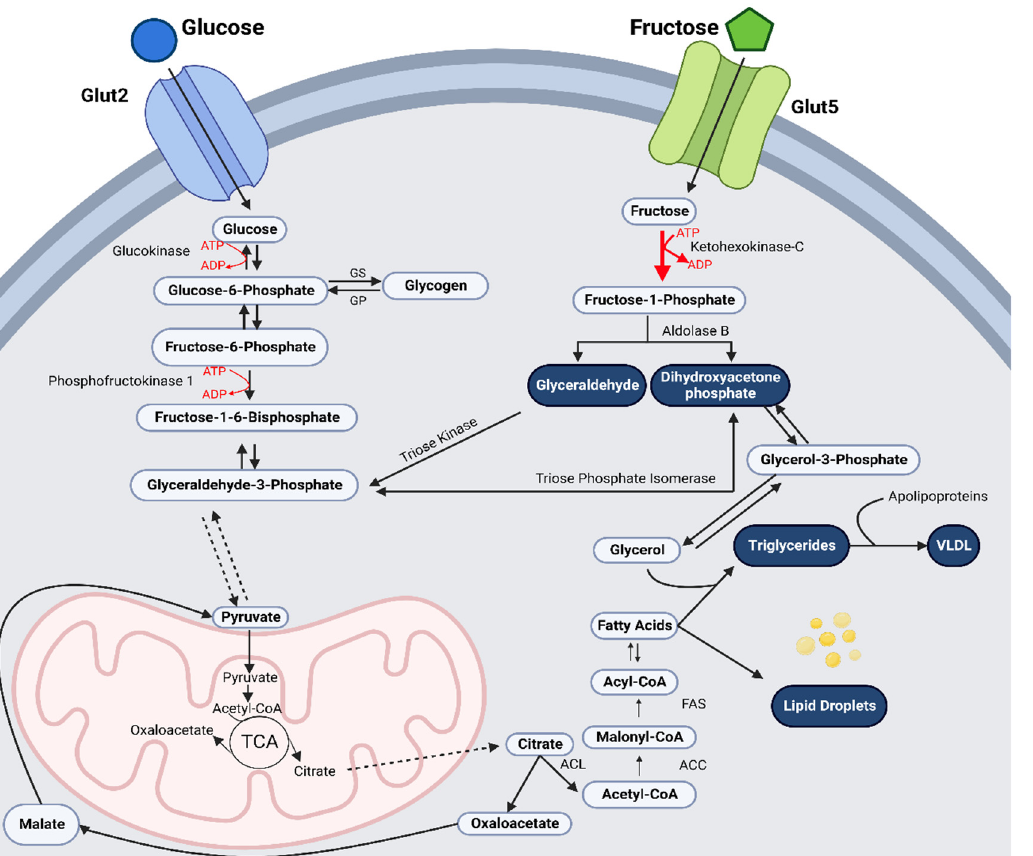
Figure 1. Fructose Hepatocyte Uptake and Metabolism. Fructose immediately bypasses phosphofructokinase, a main regulator of glycolysis, and is instantly phosphorylated by fructokinase/ketohexokinase to produce fructose-I-phosphate (fructose-1-P). Aldolase B initiates the lysis of fructose-1-P to produce dihydroxyacetone phosphate (DHAP) and glyceraldehyde. Triose kinase converts glyceraldehyde into glyceraldehyde-3-phosphate (Glyc-3-P). Fructose enters glycolysis at the tri-phosphate level without encountering rate-limiting and regulatory enzymes, providing an unregulated source of both glycerol-3-phosphate (G-3-P) and acetyl-CoA, increasing pyruvate availability to enter the mitochondrion for energy production or hepatic de novo lipogenesis. Primary hepatic metabolites of fructose include glucose, glycogen, lactate, uric acid, free fatty acids (FFA), very low-density lipoproteins (VLDL) and triglycerides (TAG). Diagram created with